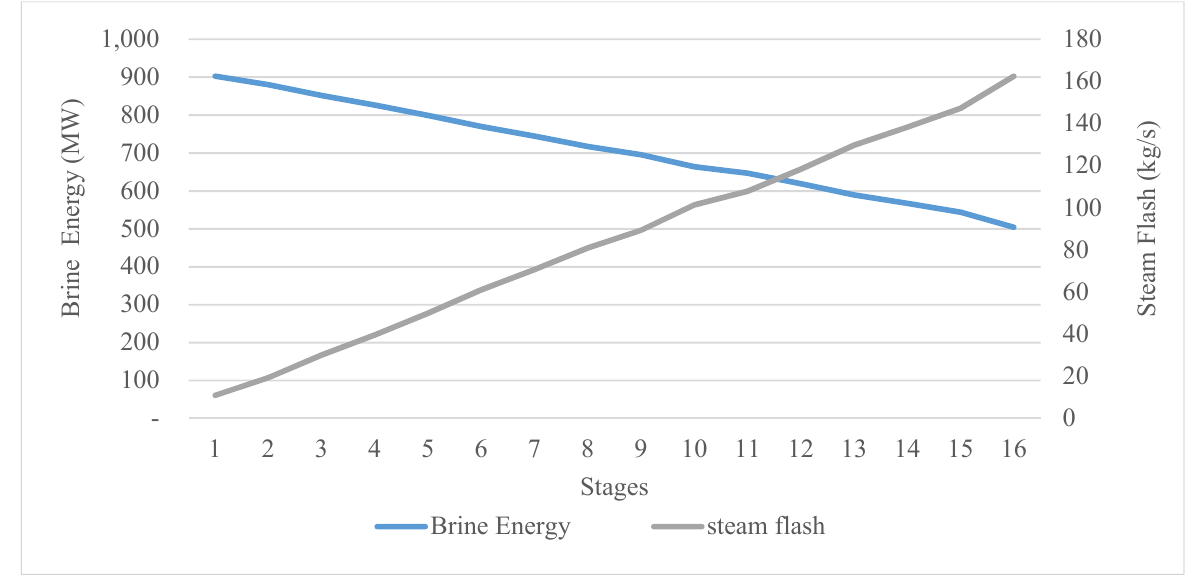
Figure 7. Brine energy and steam flash per stage.